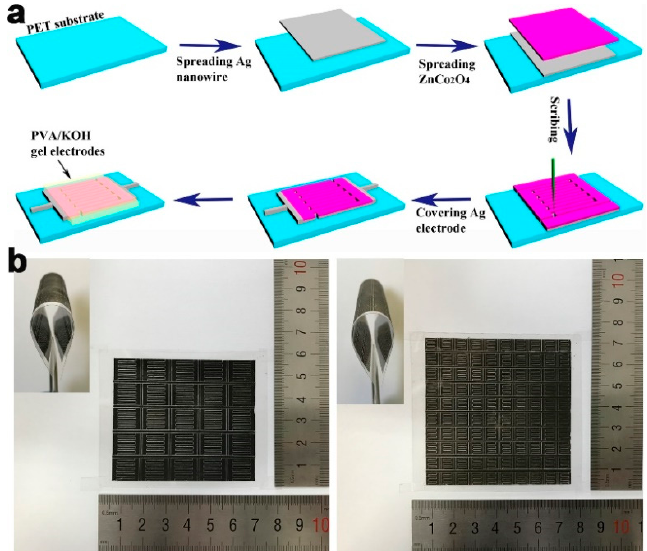
Figure 7. ( a ) Schematic illustration for the fabrication of flexible all-solid-state on-chip MSCs based on ZnCo 2 O 4 nanowires electrodes on PET substrate; ( b ) Photographs of the large scale on-chip MSCs arrays. The figure has been reproduced with permission from Wiley